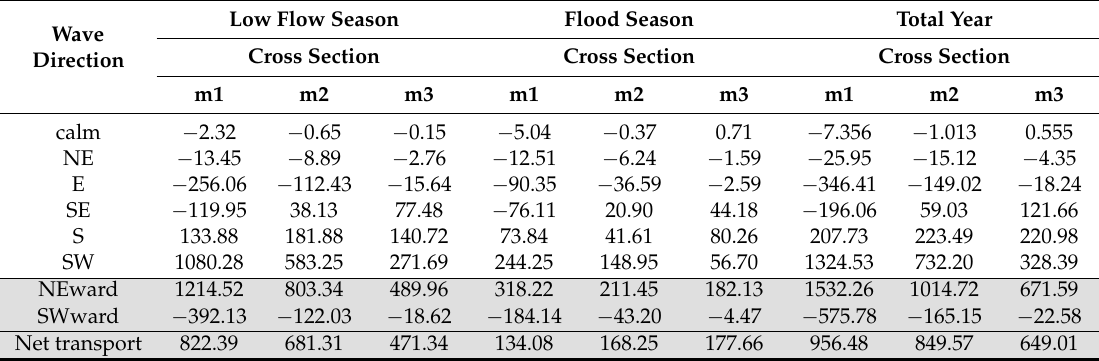
Table 4. Total sediment flux (10 3 tons) transported across sections per year. (Positive values represent sediment transport from the SW to NE, negative values from the NE to